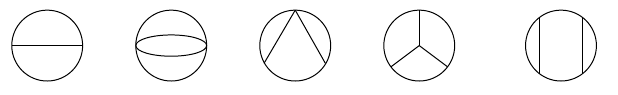
Figure 6 . Type of diagrams surviving at order O ( β 4 )